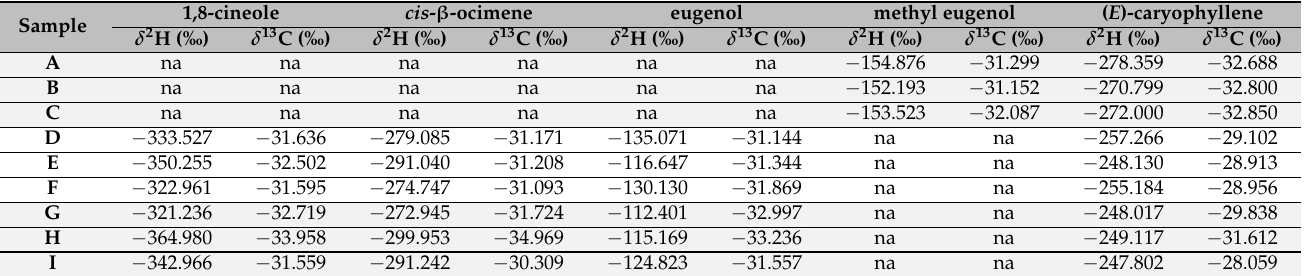
Table 2. Stable isotope ratios, δ 2 H and δ 13 C, for 1,8-cineole, cis - β -ocimene, eugenol, methyl eugenol, and ( E )-caryophyllene when compounds prominent in a sample. Values not analyzed in a sample are denoted as not analyzed (na).